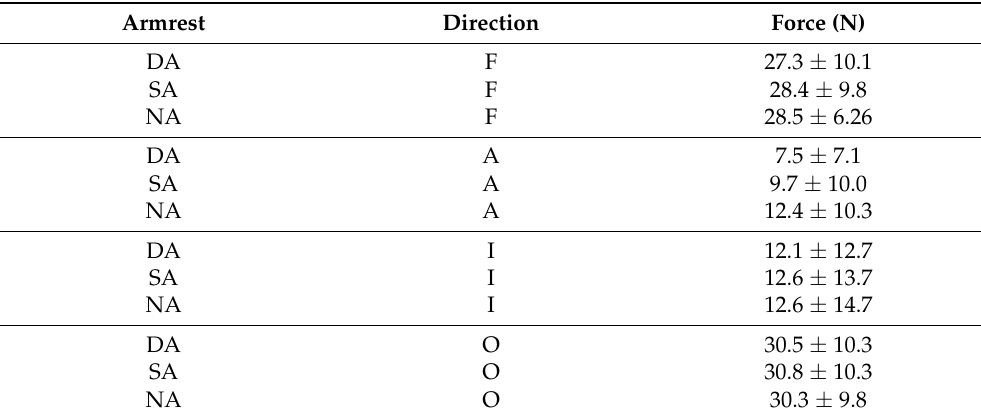
Table 6. Peak joystick input force data for each armrest condition and motion direction, expressed as mean ± standard deviation (DA = dynamic armrest, SA = stationary armrest, and NA = no armrest) movement direction (F = fore, A = aft, I = inward, and O = outward).